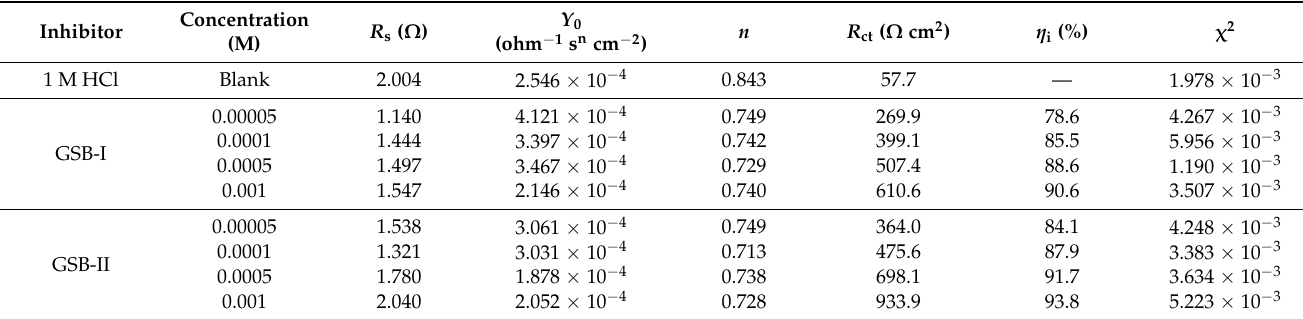
Table 2. EIS factors for the API 5L X65 steel corrosion in 1 M HCl without and with different concentrations of studied inhibitors at 298